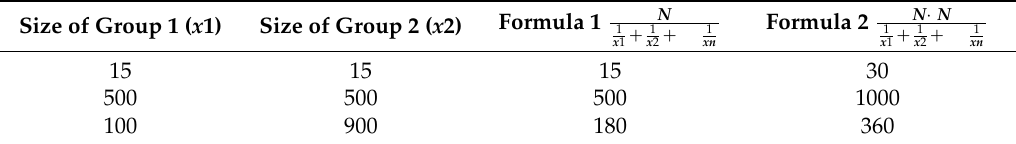
Table 2. Various Values for the Harmonic N of Data Points with Two Samples Using Two Different